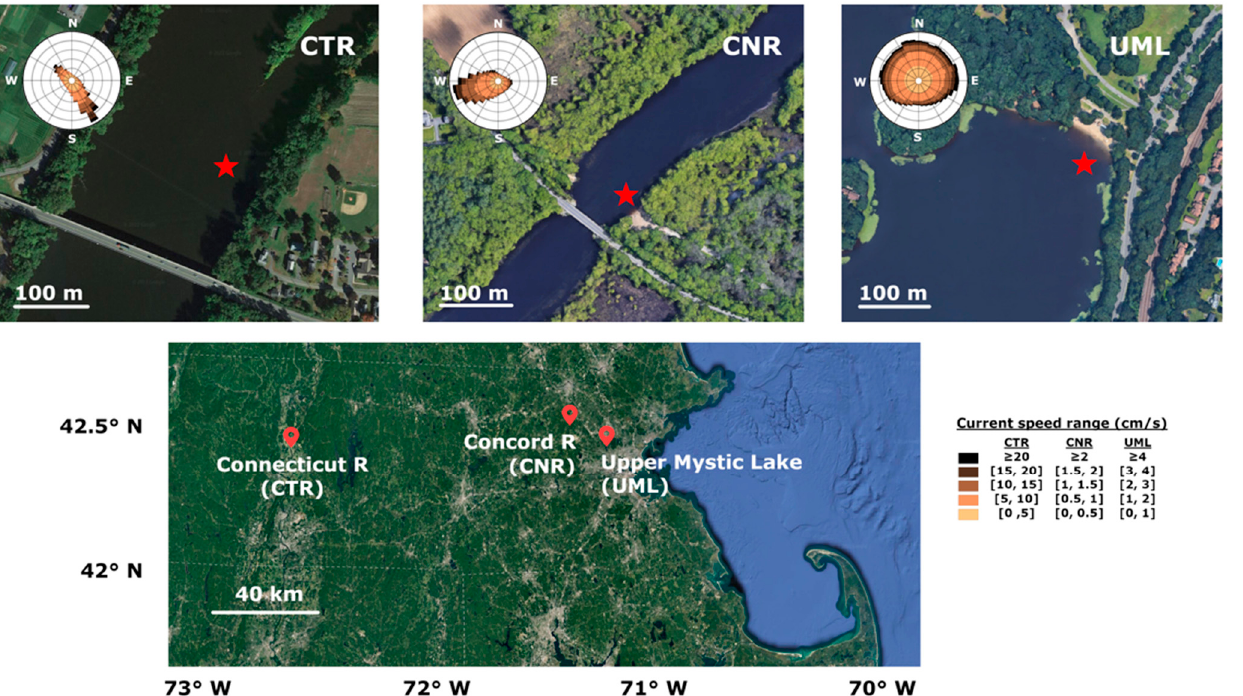
Figure 3. Location map of three field sites at which the eddy flux instrument was deployed, with current rose of horizontal water velocities measured during AEC deployment. Current roses indicate direction that current is traveling towards. Star indicates location of instrument deployment.